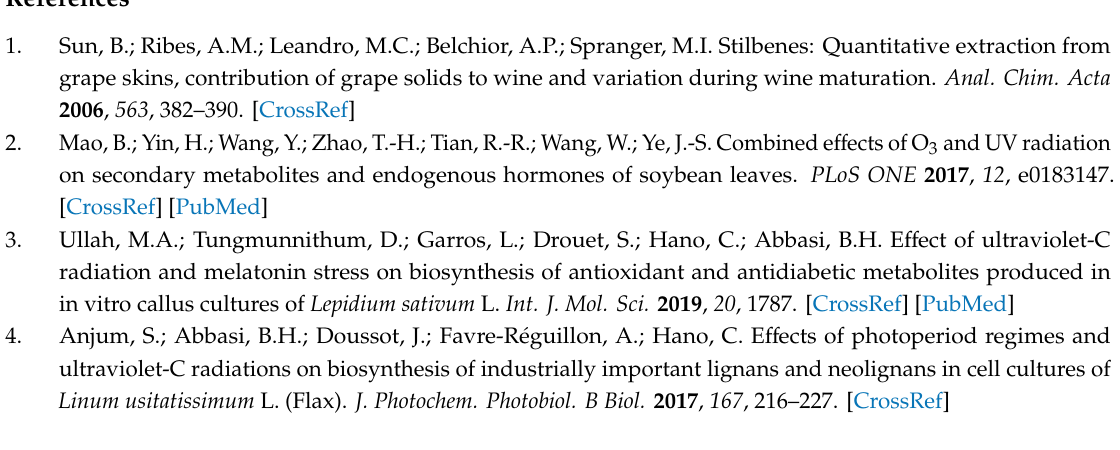
Table S1: E ff ect of UV-C (260 nm, 5 min) irradiation on isoflavone concentrations in di ff erent cultivars of Glycine max . Table S2: Isoflavone concentrations in Glycine max (cv. Daepung) after UV-C (260 nm)